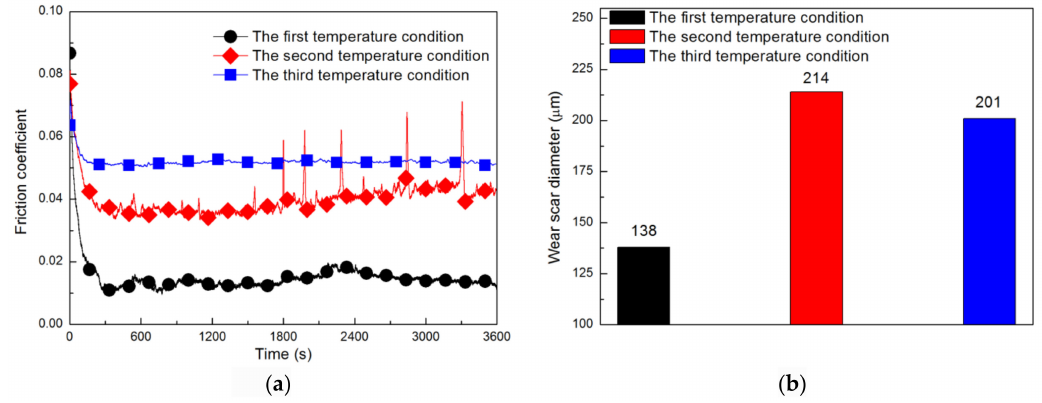
Figure 4. Friction coefficient curves ( a ) and the average wear scar diameters ( b ) of 5CB+0.15 wt.% G suspension under three temperature conditions.